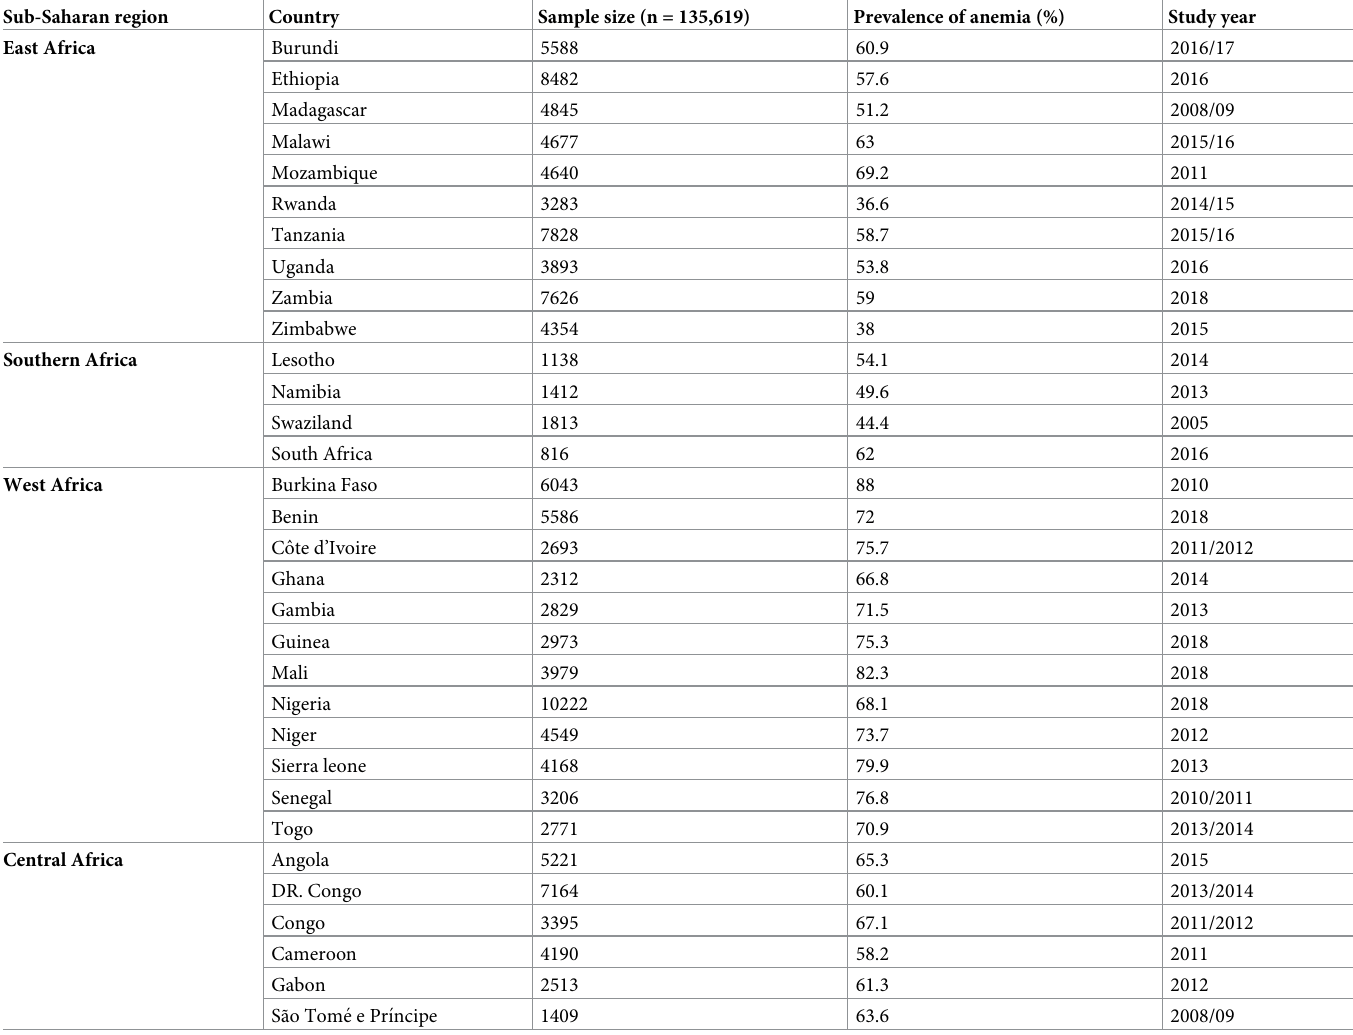
Table 1. Number of study participants for this study, and survey years. Sub-Saharan